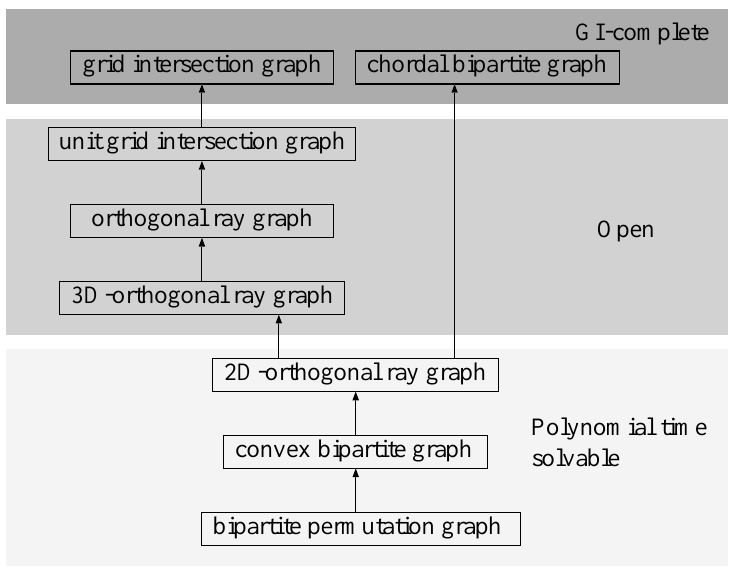
Fig. 1: Hierarchy of the graph classes and computational complexity of the GI